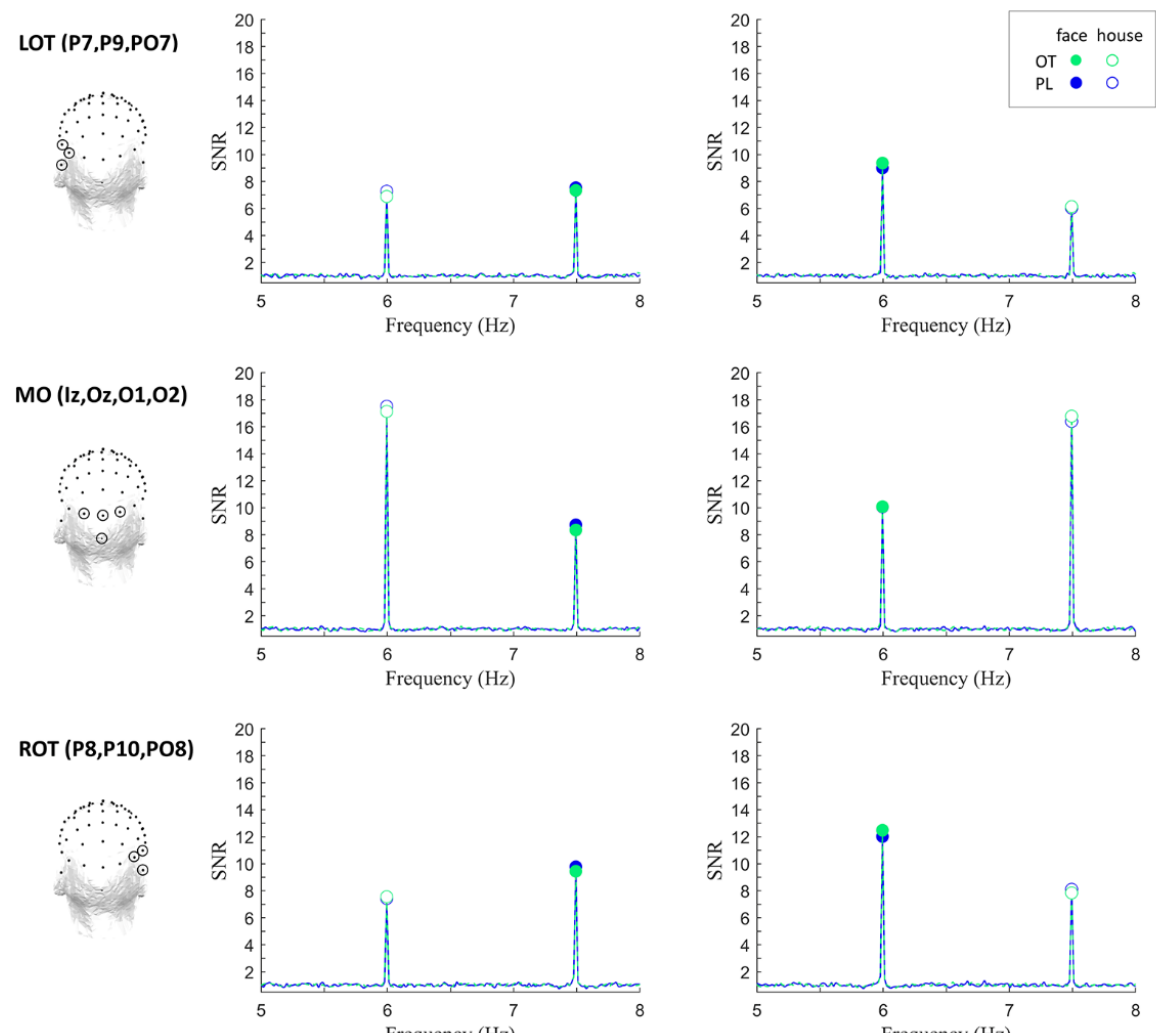
Figure 2. Grand-averaged signal-to-noise ratio (SNR) spectra at the first harmonic of the target frequencies. Data were plotted for the left occipito-temporal (LOT: P7, P9, PO7) region (upper panel), the medial occipital (MO: Iz, Oz, O1, O2) region (middle panel) and the right occipito-temporal (ROT: P8, P10, PO8) region (lower panel). Full circles illustrate the neural responses to faces (i.e., on the left faces were presented at 7.5 Hz, while the right faces were presented at 6 Hz), and empty circles illustrate the neural responses to houses (i.e., on the left houses were presented at 6 Hz, while on the right houses were presented at 7.5 Hz). Green lines indicate the oxytocin treatment, while blue lines indicate the placebo